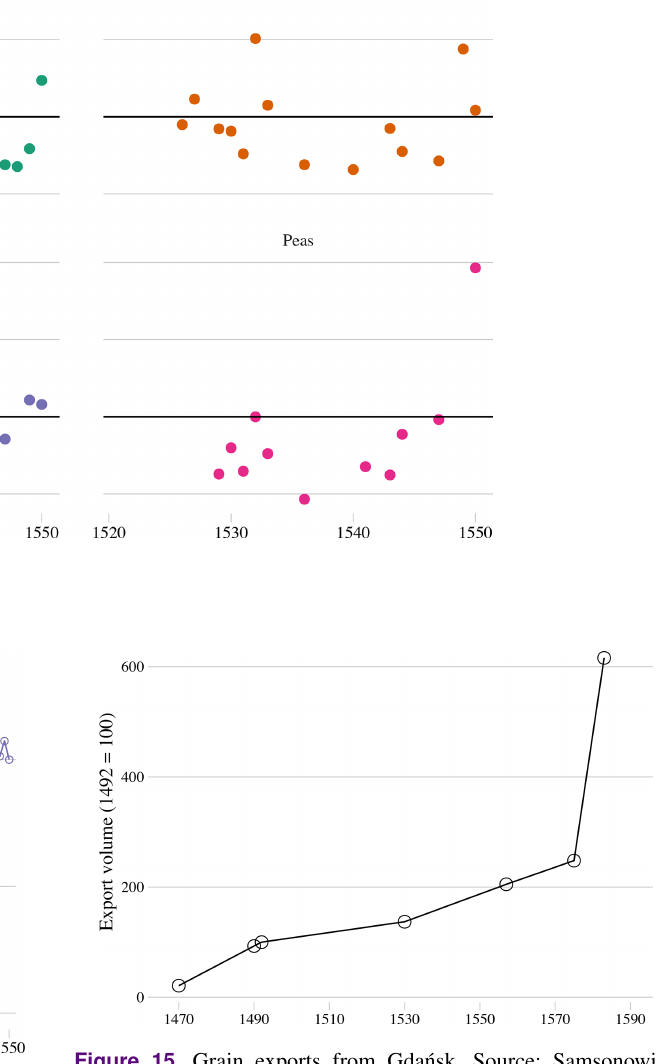
Figure 14. Wine prices. Source: Pelc (1935), Hoszowski (1928), Wola´nski (1996).